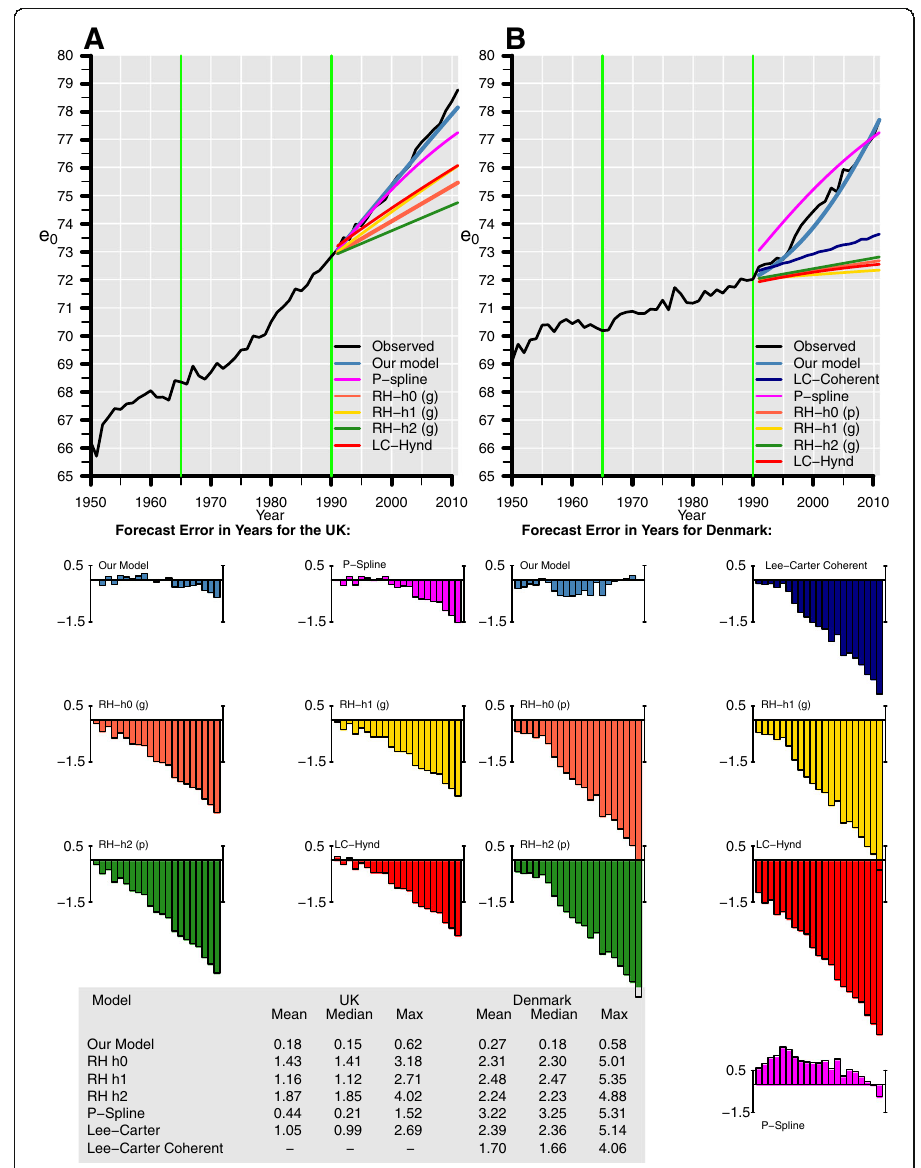
Fig. 9 Observed ( black line ) and forecasted life expectancy at birth ( e 0 ) of our model ( blue ), the P-spline approach ( magenta ), the LC model ( red ), and four of its variants, h0 ( light red ), h1 ( yellow ), h2 ( green ), and coherent ( navy blue ), for men in the UK ( left ) and Denmark ( right ). The validating forecasts from 1991 to 2011 rely on data from 1965 to 1990 ( green vertical lines ). We combine the mortality trends of Danish and Swedish men in our model as well as in the coherent LC forecast. In the RH models, (p) and (g) denote Poisson and Gaussian errors, respectively. Forecast errors are shown for all